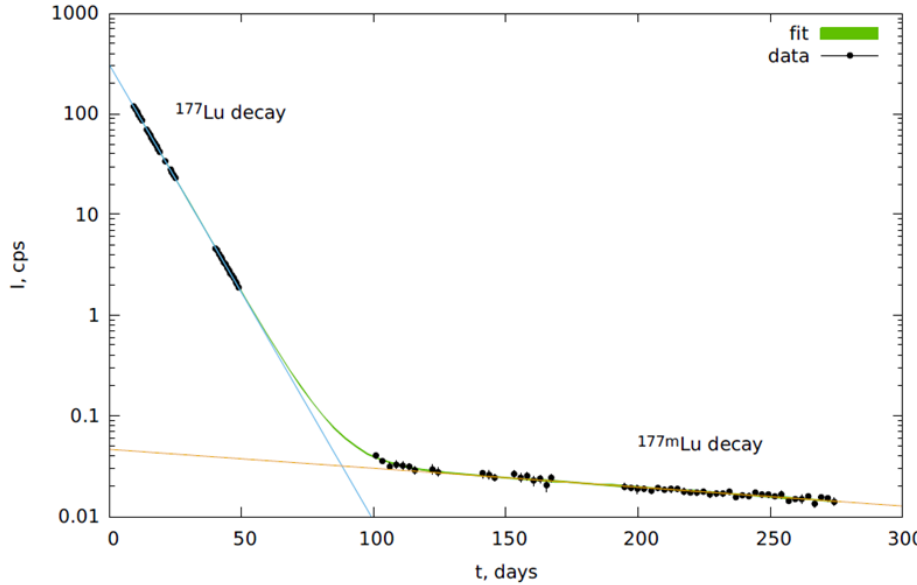
Figure 3. Dependency of count rate of 208 keV line, which is present in both 177 Lu and 177m Lu spectra, on time after irradiation. Dots—experimental data, lines—fit. Blue lines—fit of 177 Lu decay, orange lines—fit of 177m Lu decay Table 2. 177m Lu/ 177 Lu activity ratios in production of 177 Lu via different methods.